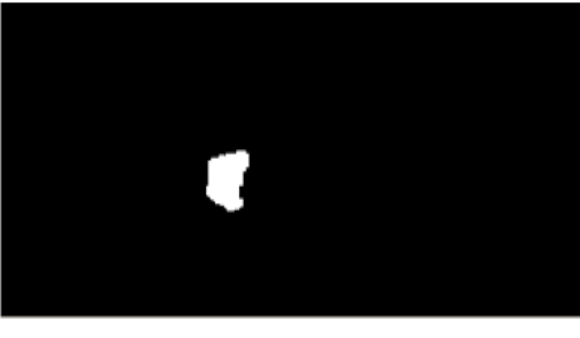
Figure 6. Common area of the projected images of cameras 1 and 2 in Figure 4c.